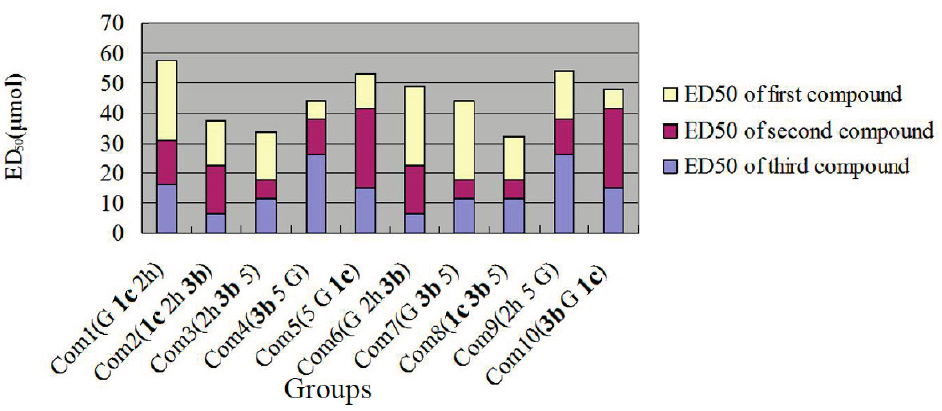
Figure 3. Combinations and activity